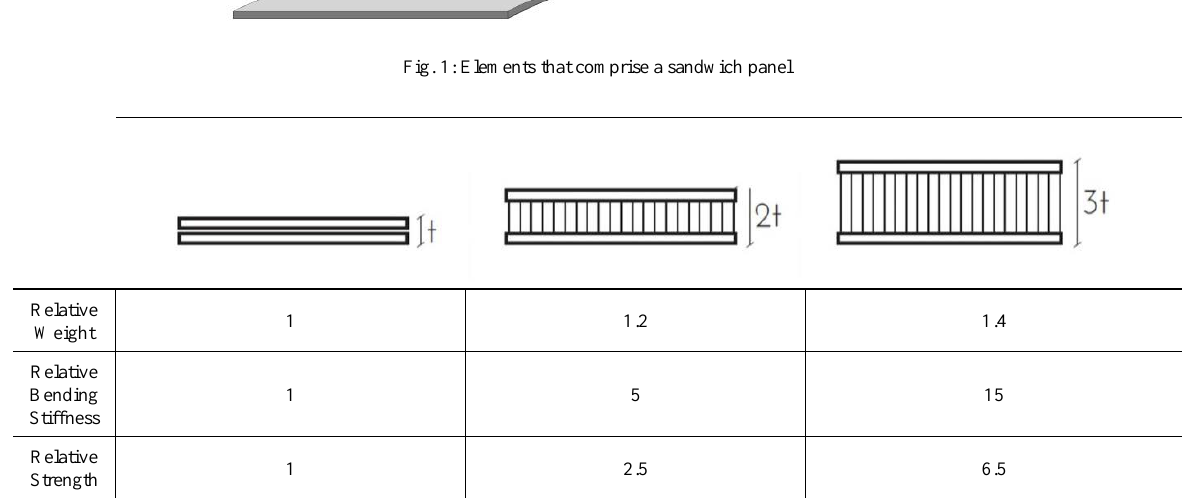
Fig. 2: Benefit of Sandwich